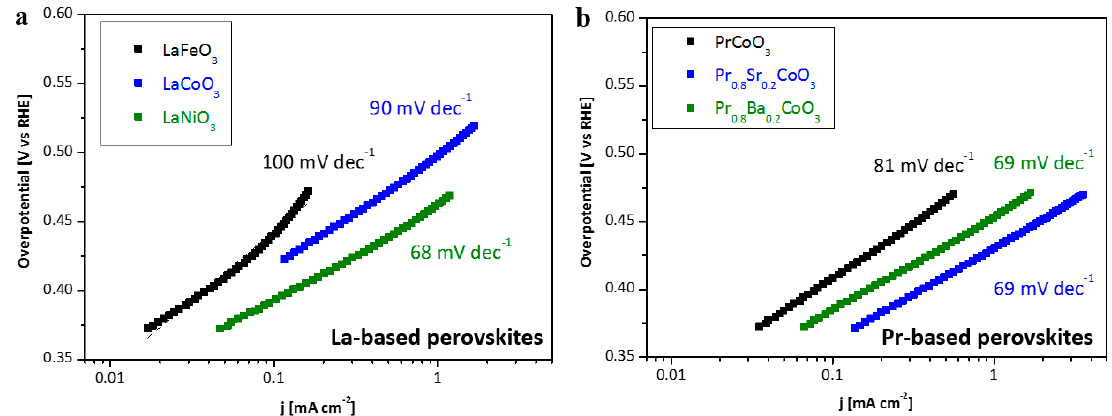
Figure 4. Tafel plots of the oxygen evolution obtained from the cyclic voltammograms of ( a ) La-based perovskites, and ( b ) Pr-based perovskites.